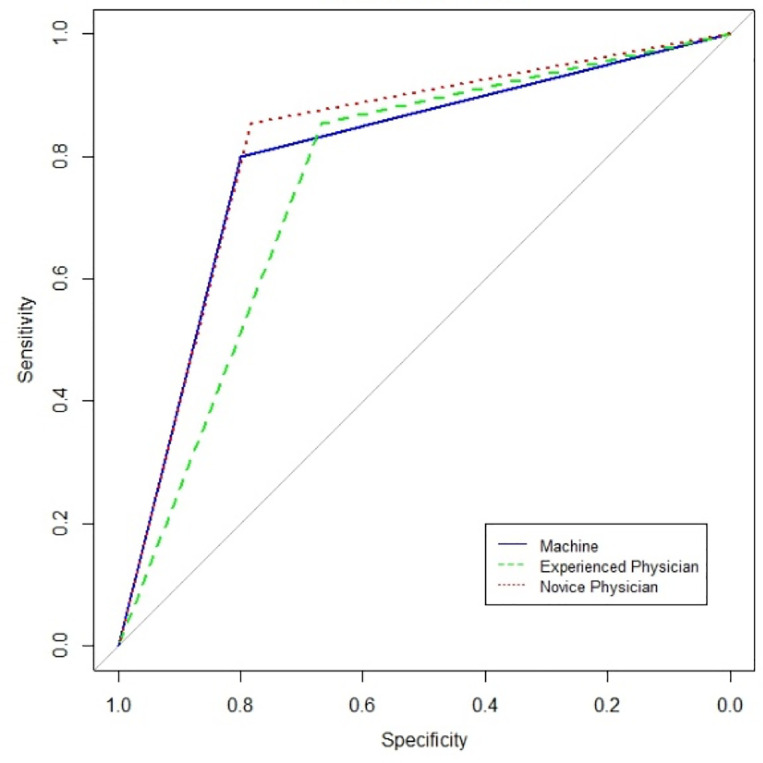
ROC curves by group.